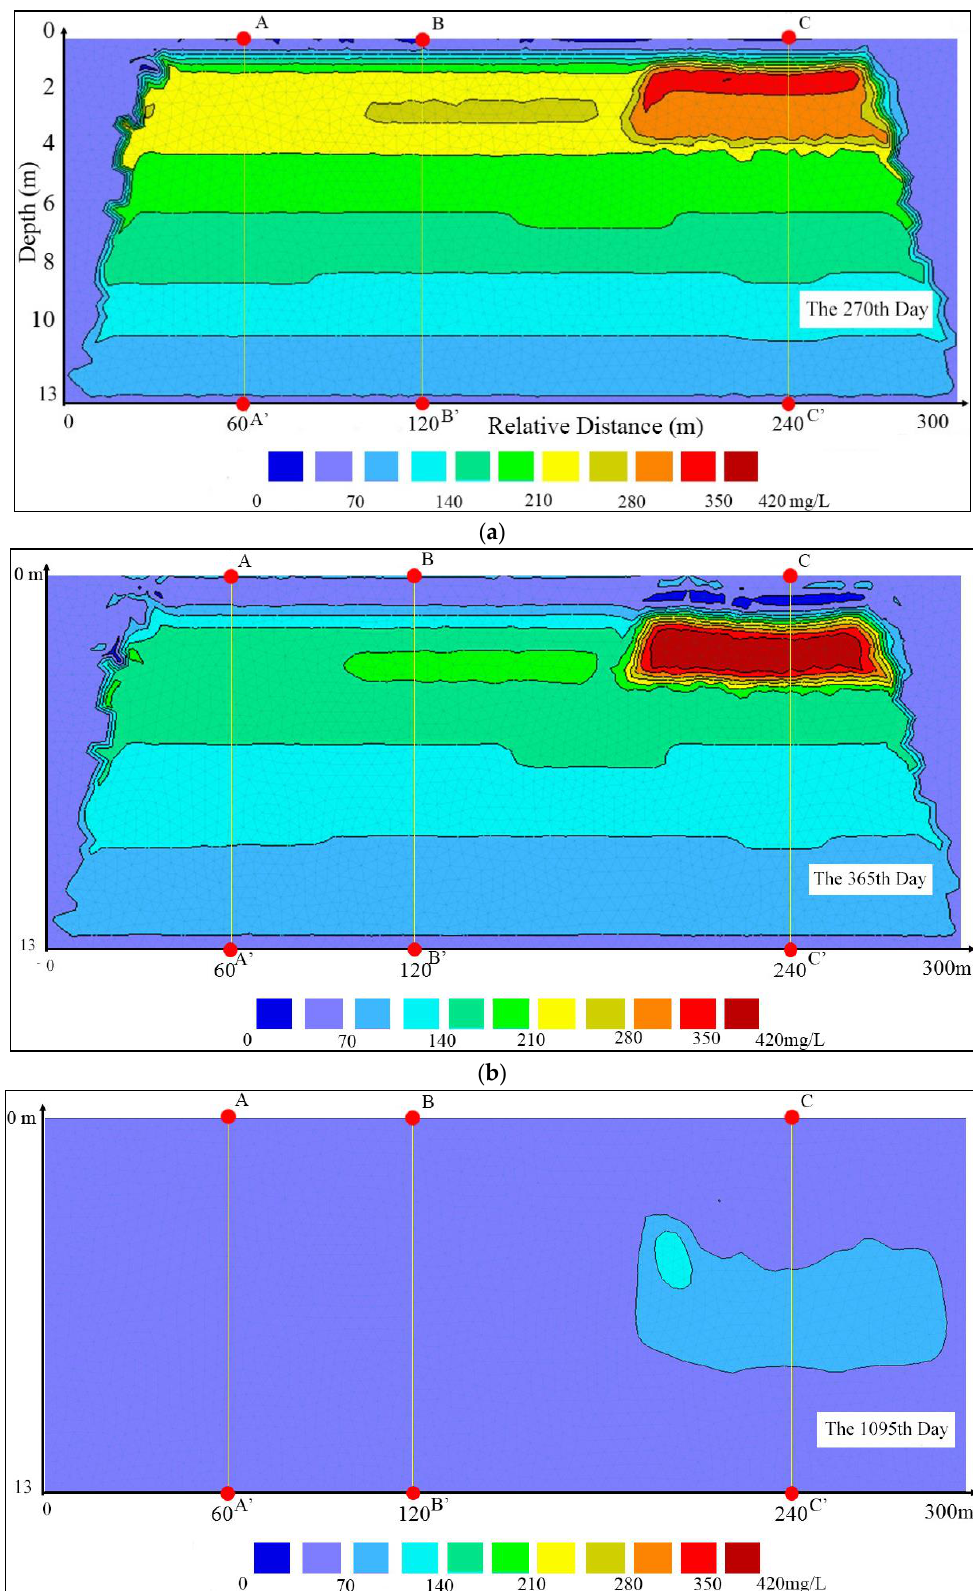
Figure 5. NO 2 − distribution after ( a ) 270 days; ( b ) 365 days; and ( c ) 1095 days. Figure 5. NO − distribution after ( a ) 270 days; ( b ) 365 days; and ( c ) 1095 2